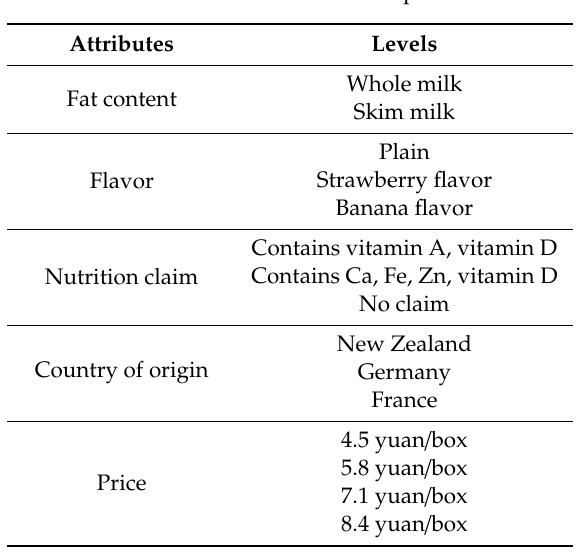
Table 1. Attributes and levels of imported